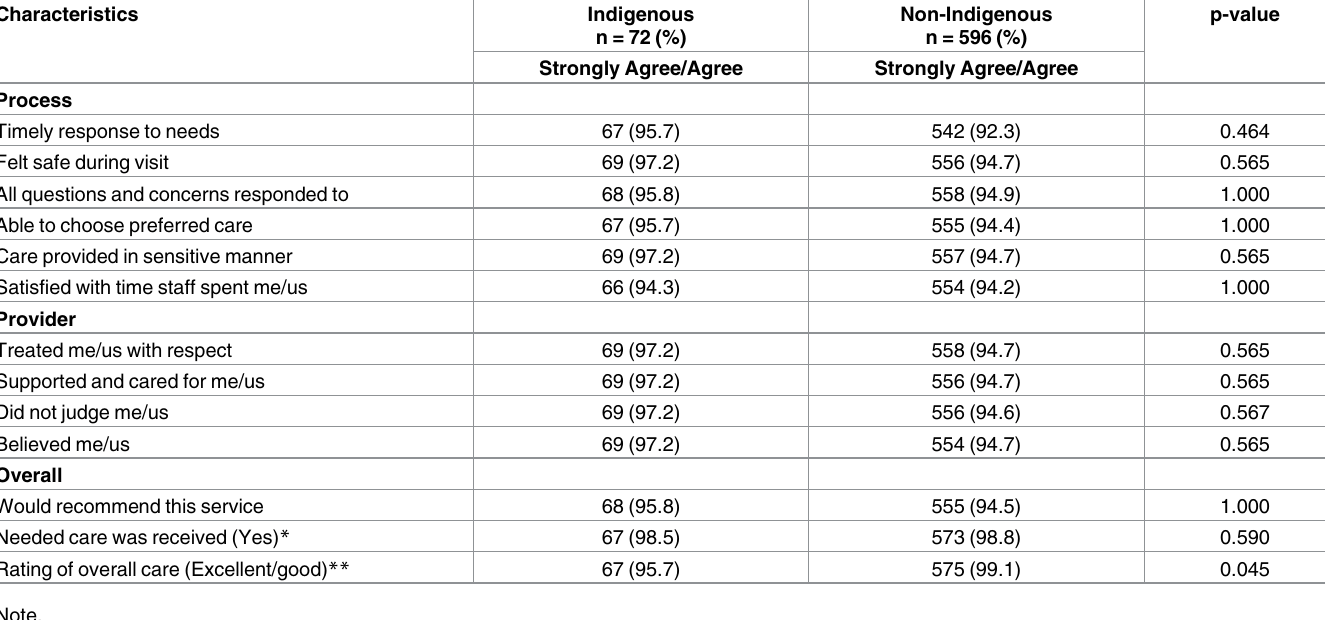
Table 6. Satisfaction with servicesof sexually assaulted adolescent and adult women who presented to Sexual Assault/Domestic Violence Treat- ment Centres, by Indigenous